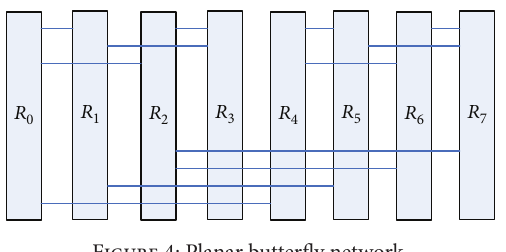
Figure 4: Planar butterfly network.